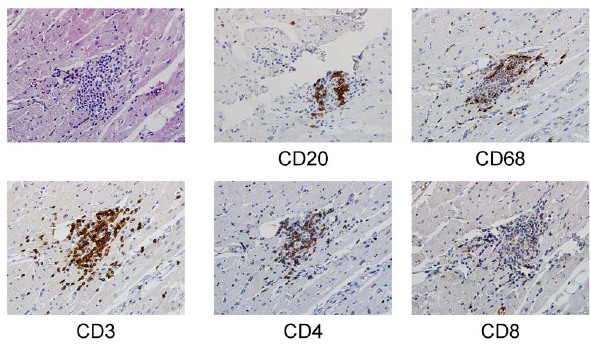
Figure 5. Immunohistochemistry of myocardial tissue. Upper left panel: H&E stain. Antibody specificity used for immunoperoxidase staining is listed below remaining panels. (All sections at 400X)